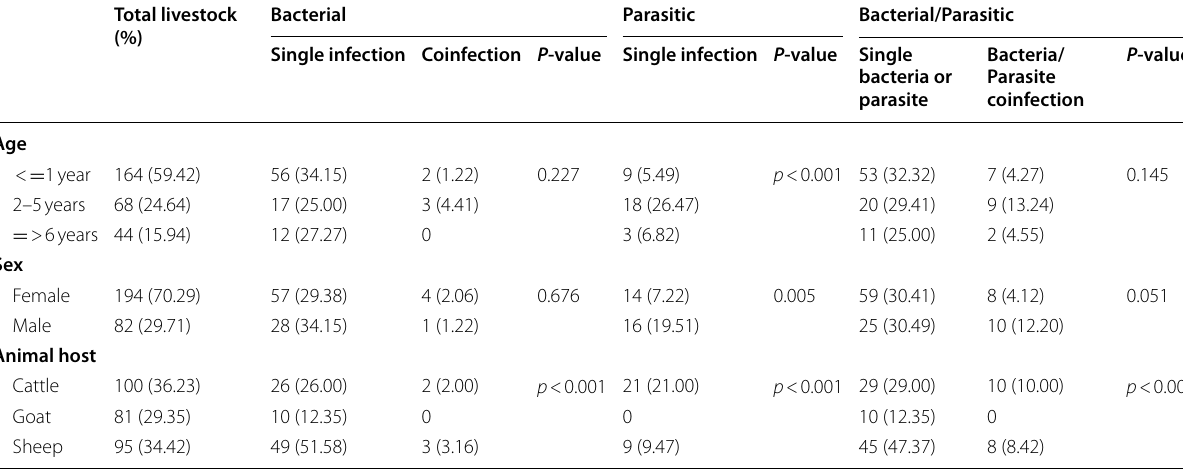
Bacteria/ bacteria or parasite